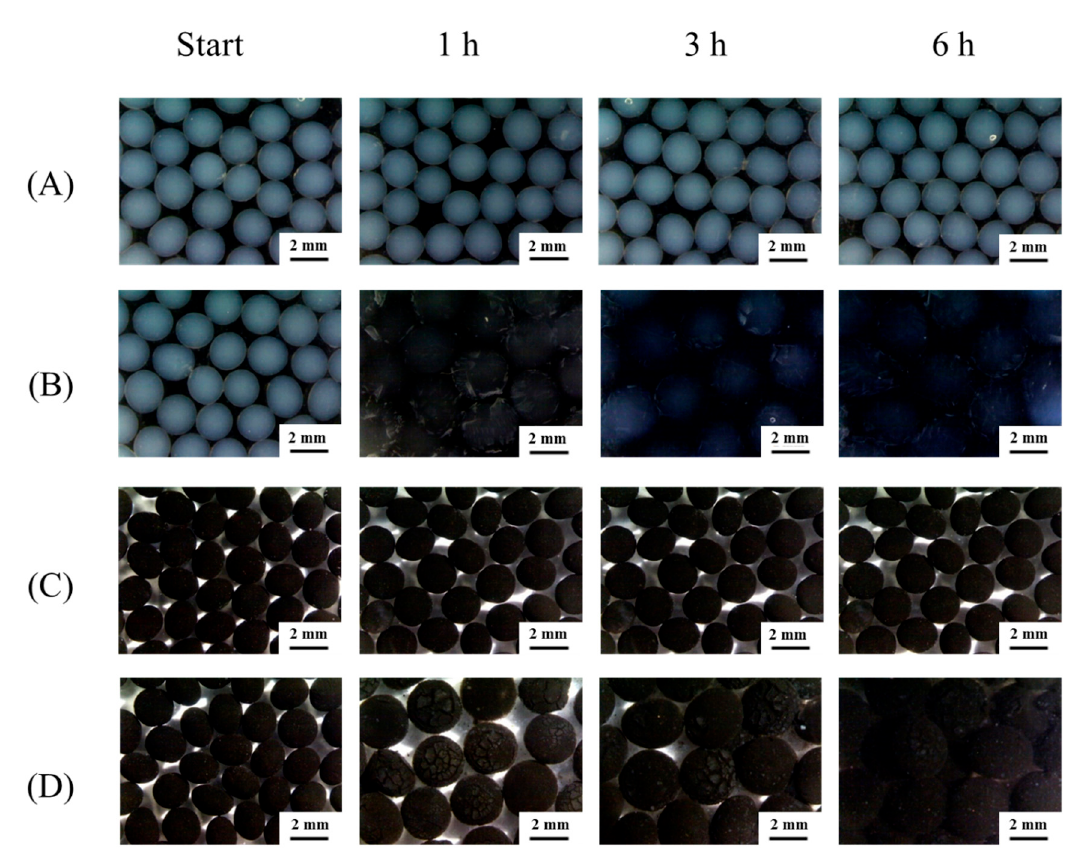
Figure 4. The degradation of alginate beads in various pH